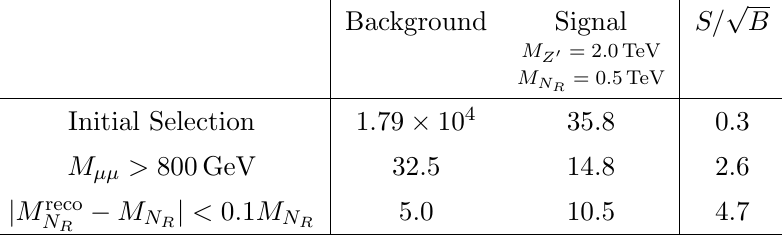
Table 1 . Expected number of events with 3000 fb (cid:0) 1 for a benchmark signal